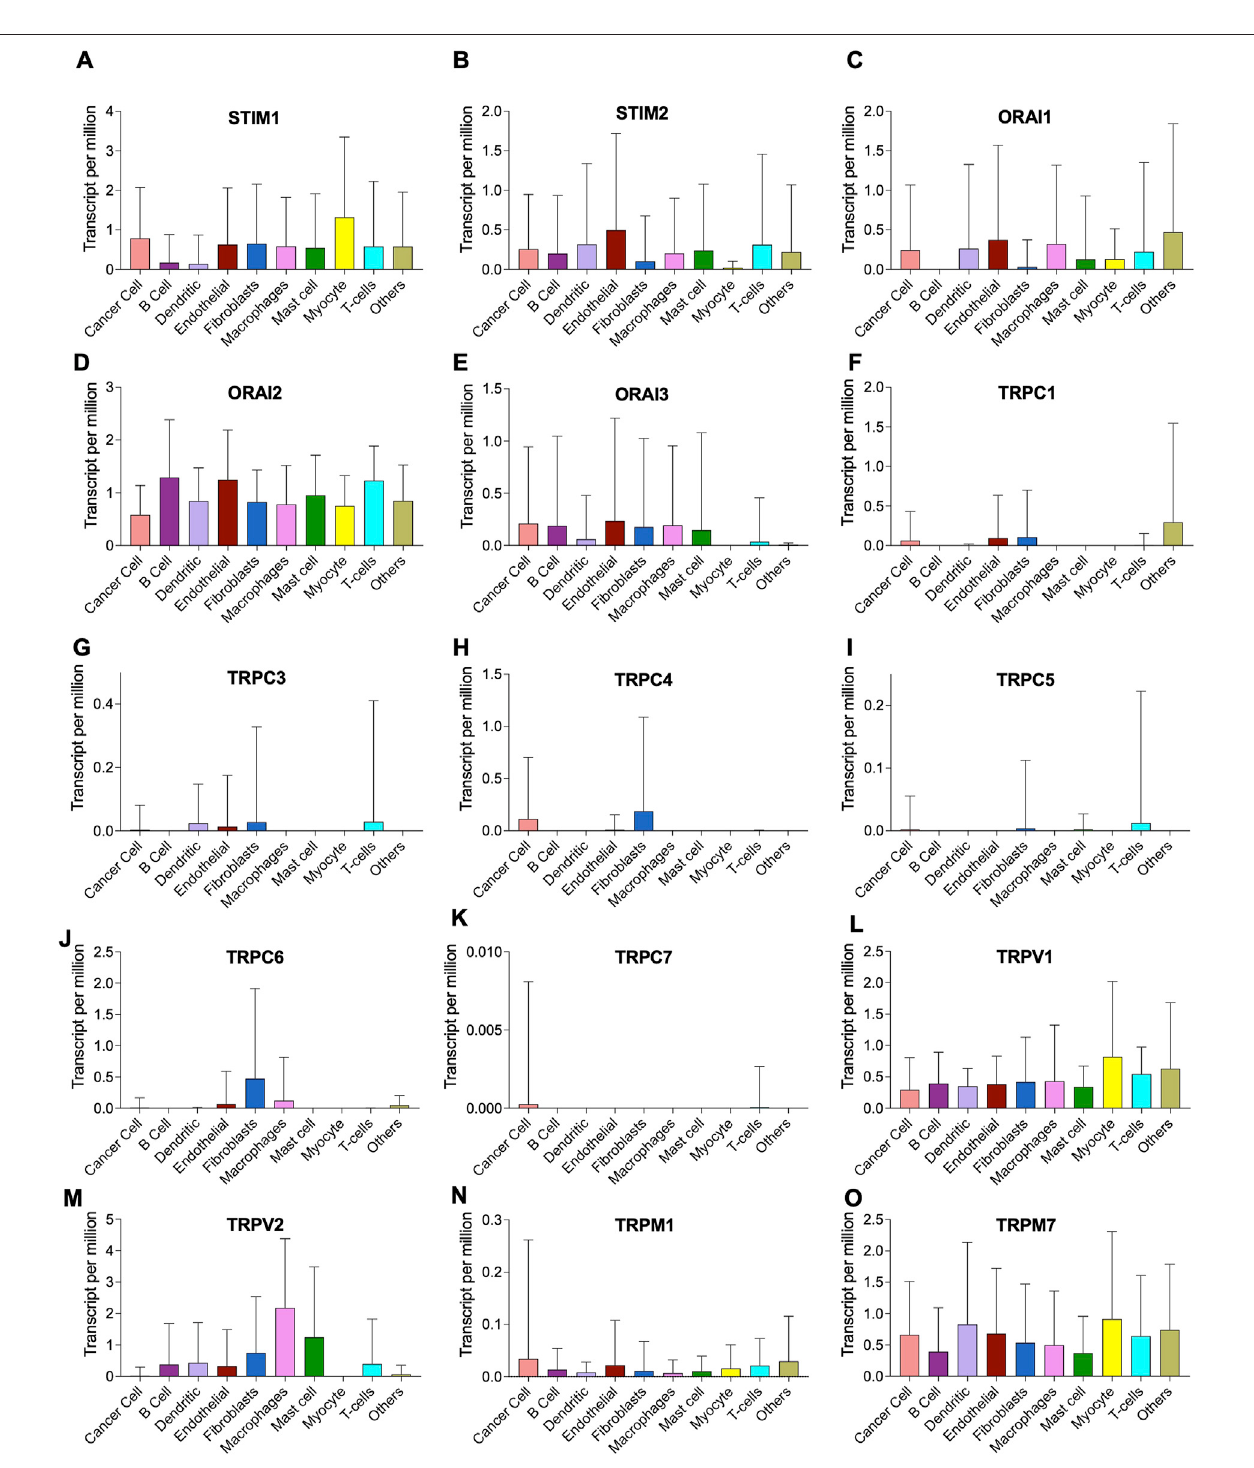
FIGURE13| Heterogenousexpression ofSOCsintumor microenvironment. (A-O) Theexpression datafromGSE103322comprisingthedataof5,902cellsfrom 18 head and neck cancer tissues was downloaded from NCBI GEO website. The data comprised of different cell populations including cancer cells, B cells, dendritic cells,endothelialcells, fi broblasts, macrophages, mastcells,myocytes,TcellsandothercellsTheexpressionlevelsofeachSOCsinthesedifferentcelltypesareplotted using Graphpad prism software version 9.2.1.